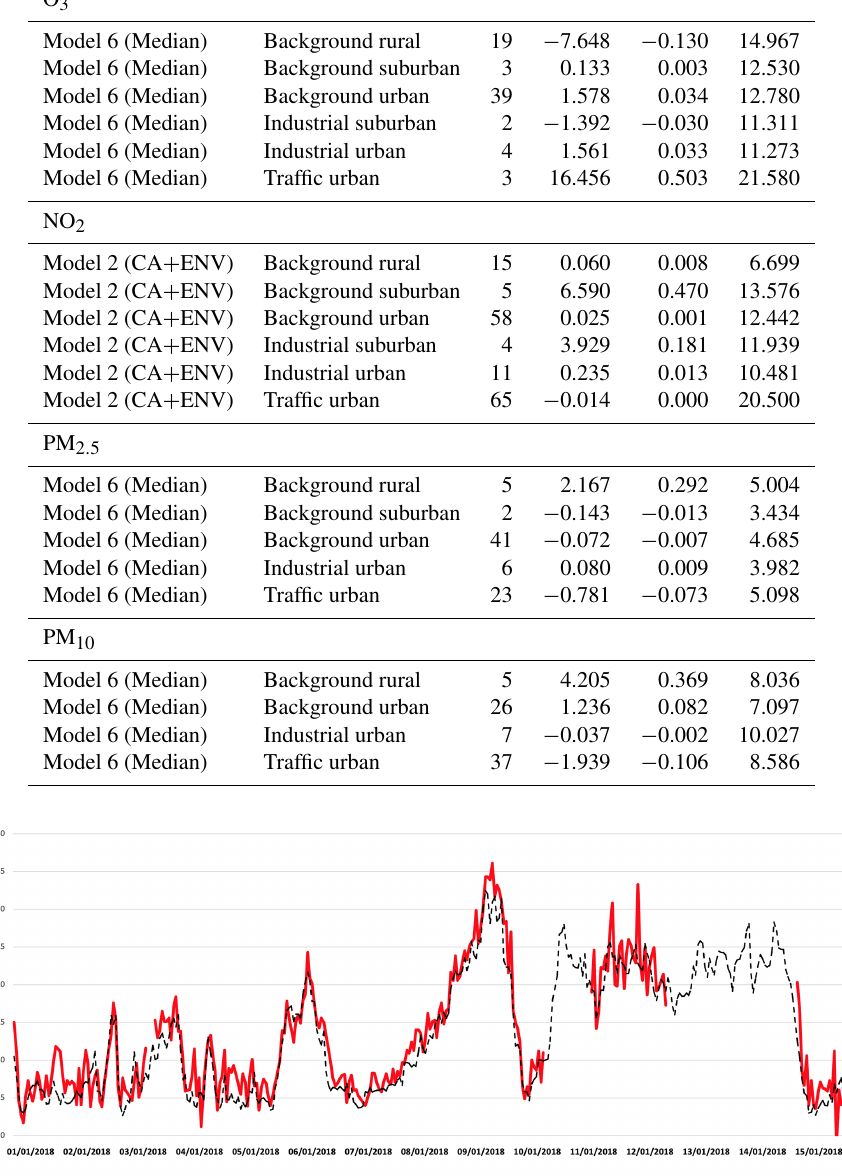
Figure 12. Imputed (black) and real (red) TS comparison for PM 2 . 5 at London Eltham station from 1 to 15 January 2018.